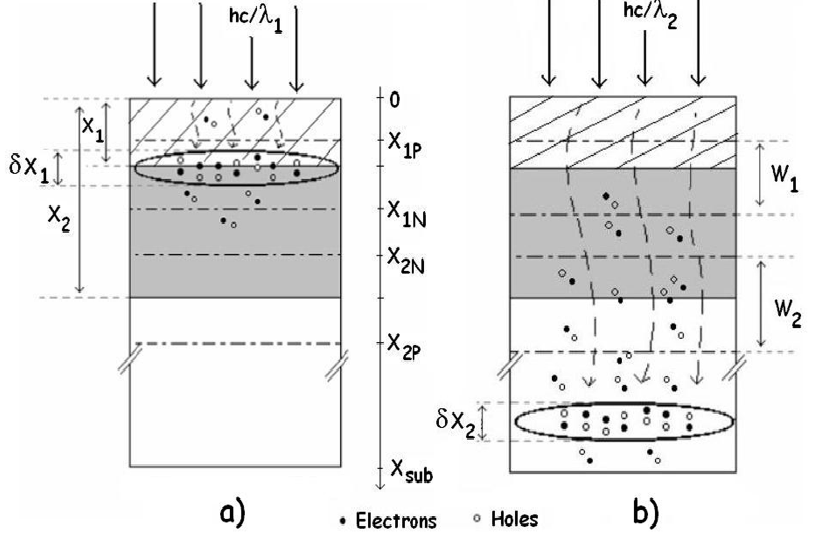
Figure 4 . Photo-generated carriers inside the BDJ detector in the case of (a) blue light ( λ ~450 nm) and (b) red light ( λ ~680